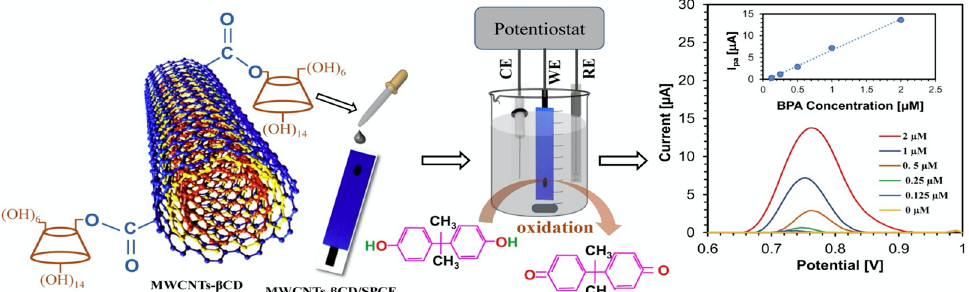
Figure 5. CD-linked multiwalled carbon nanotubes (MWCNTs- β CD) deposited onto screen printed electrodes (SPCE) and employed in the detection of Bisphenol A. Reproduced with permission from Ali et al. [92], Sens. Actuators B Chem.; published by Elsevier, 2020.